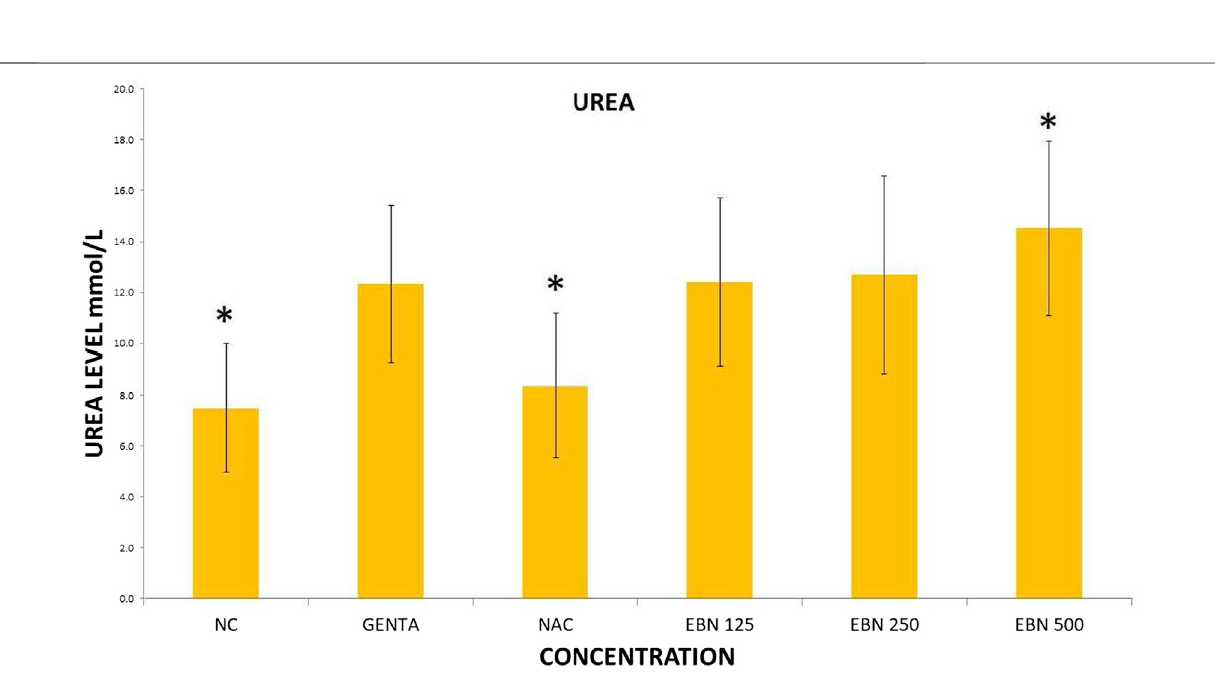
Frontiers in Pharmacology |